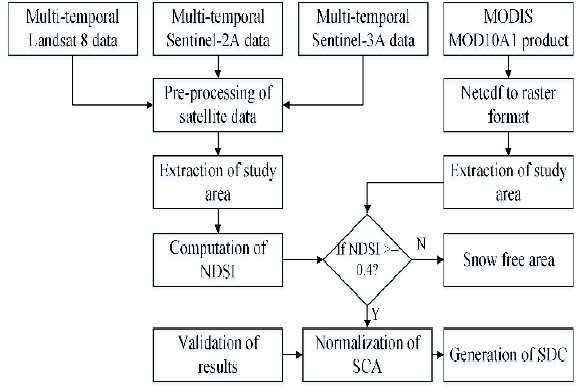
Figure 2. Flowchart of methodology followed for generation of SDC using satellite data from multiple sources